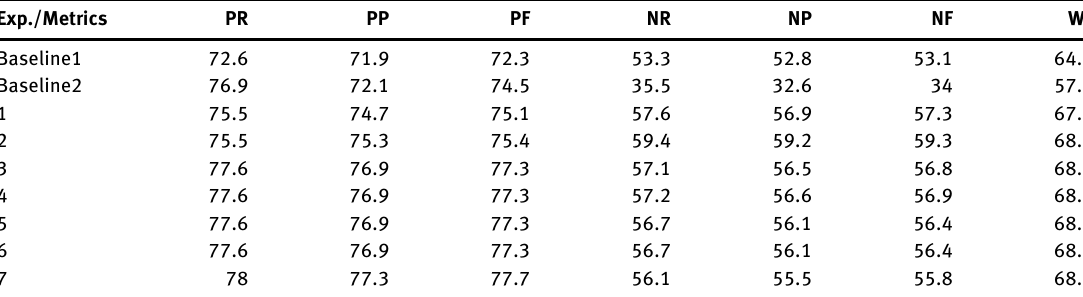
Table 6: Experimental Results for POS Subcategory